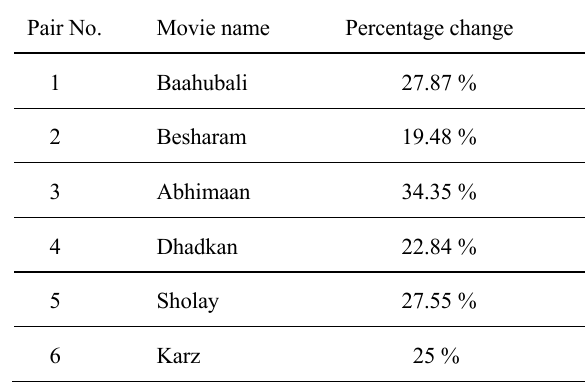
Table 3: Changes in eye movements in AOI_Video Pair